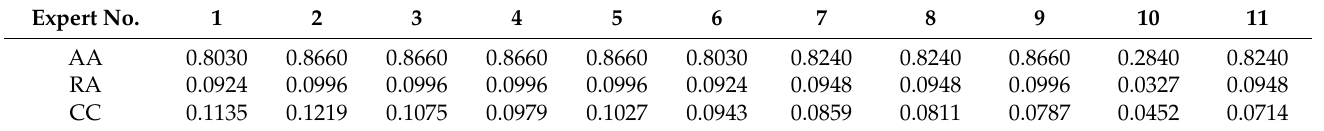
Table 7. The AA, RA, CC of BE